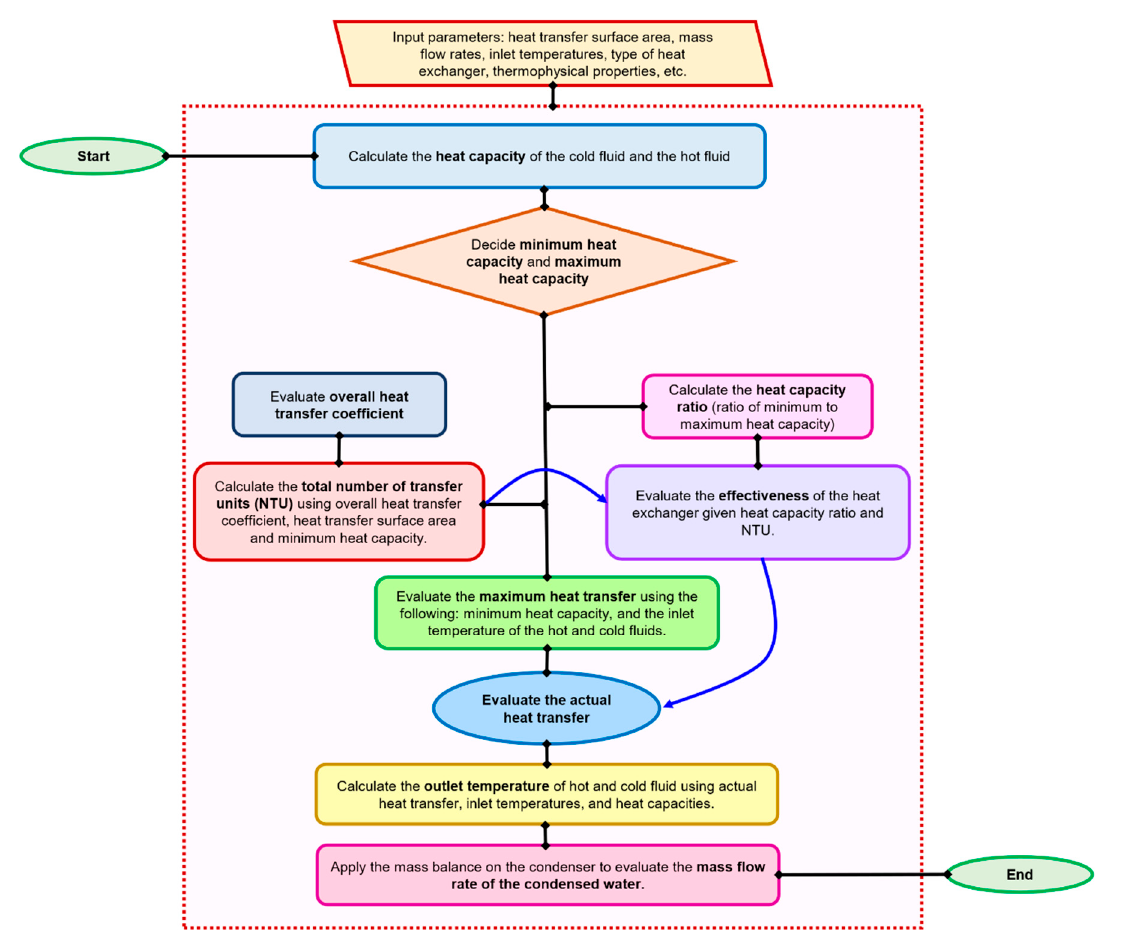
Figure 4. The methodological framework for the analysis of the dehumidifier.